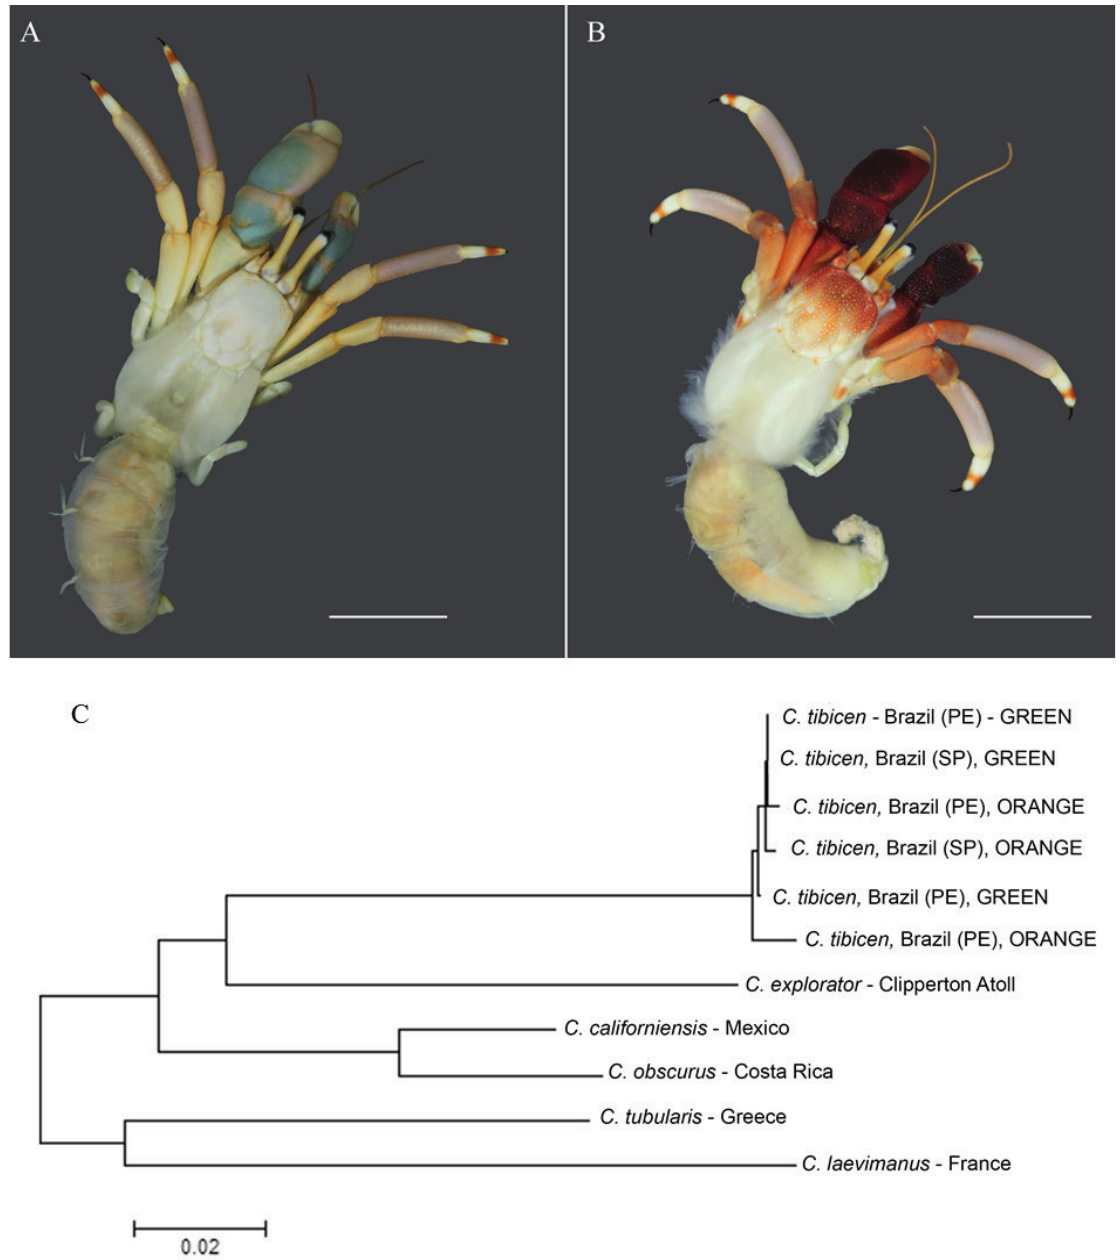
Figure 1. Specimens of Calcinus tibicen (Herbst, 1761) from two Brazilian localities (PE: Pernambuco and SP: São Paulo), showing differences in the color patterns of the chelae in life. (A) green claw male, CCDB 5328, scale bar = 10 mm. (B): orange claw male, CCDB 5327, scale bar = 11 mm (both from Pernambuco). (C) Neighbor Joining tree of C. tibicen specimens based on genetic distance for COI gene. Photos by R.C.